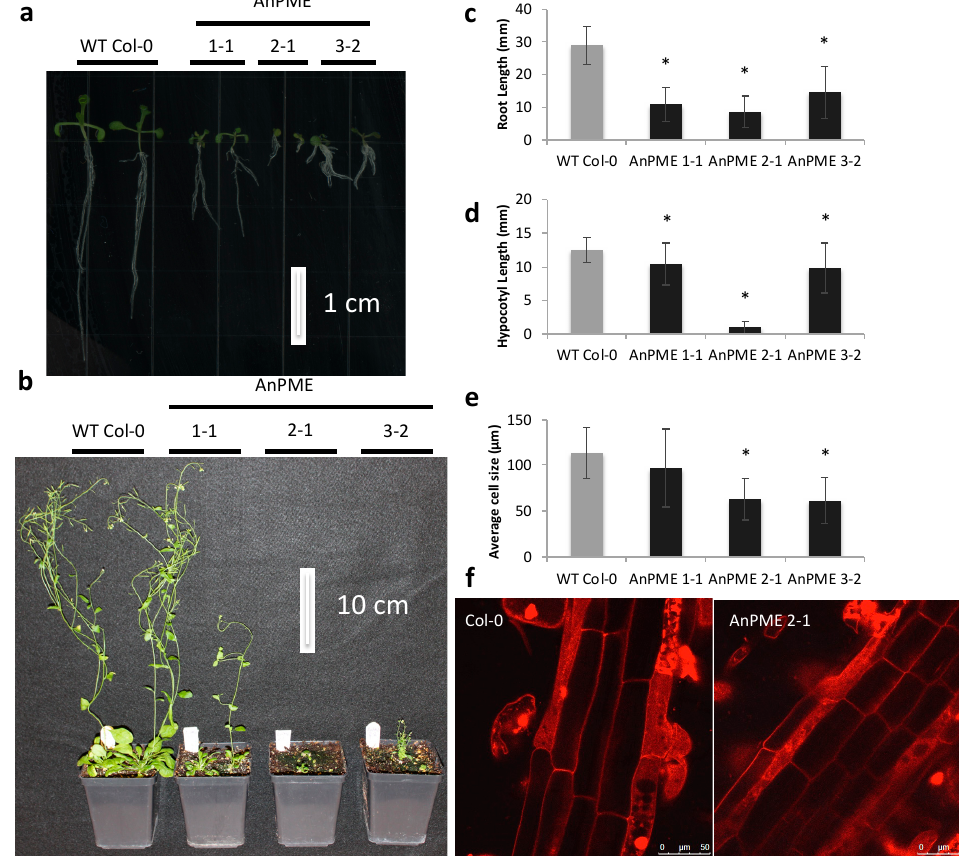
Figure 1. AnPME plants display a severe stunted phenotype. ( a ) Seven-day-old seedlings exhibit reduced root growth and leaf expansion; ( b ) five-week old AnPME plants with reduced leaf and rosette area, as well as shorter stems; ( c ) Root length is reduced in seven-day old AnPME plants ( n = 60); ( d ) Length of hypocotyls is reduced in etiolated AnPME seedlings ( n = 60); ( e , f ) Cell elongation is inhibited in AnPME plants determined through confocal imaging of propidium iodide stained root tissue ( n ≥ 18 root cells from 6 plants). Error bars represent standard deviation. Asterisks indicate statistical significance ( p < 0.05, student’s t -test).